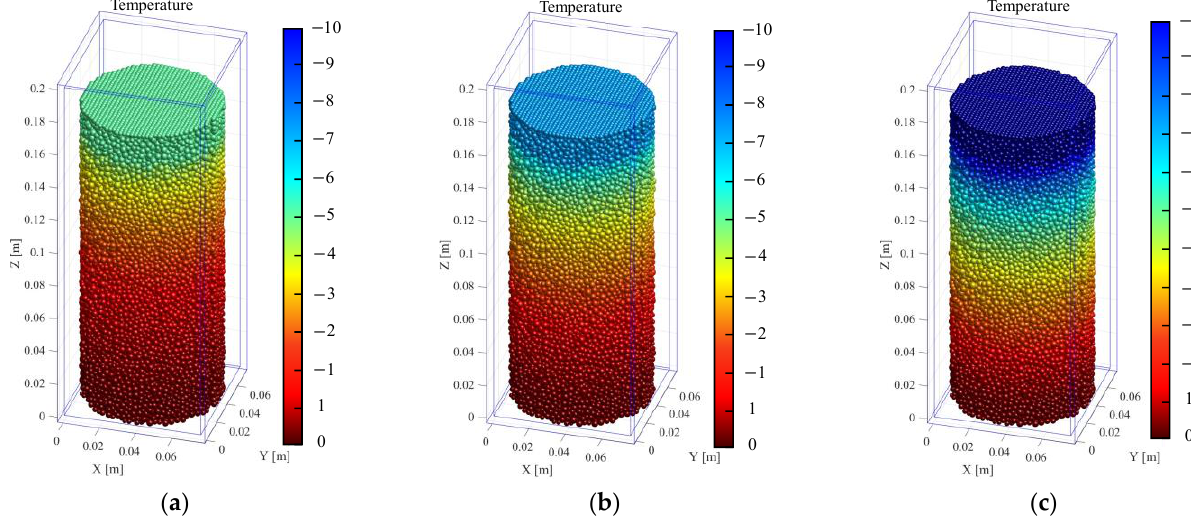
Figure 6. Temperature distribution of samples after freezing at different cold end temperatures: ( a ) the cold end temperature is − 5 ◦ C; ( b ) the cold end temperature is − 7 ◦ C; ( c ) the cold end temperature is − 10 ◦